Question: Which kind of chart has been used to present this data?
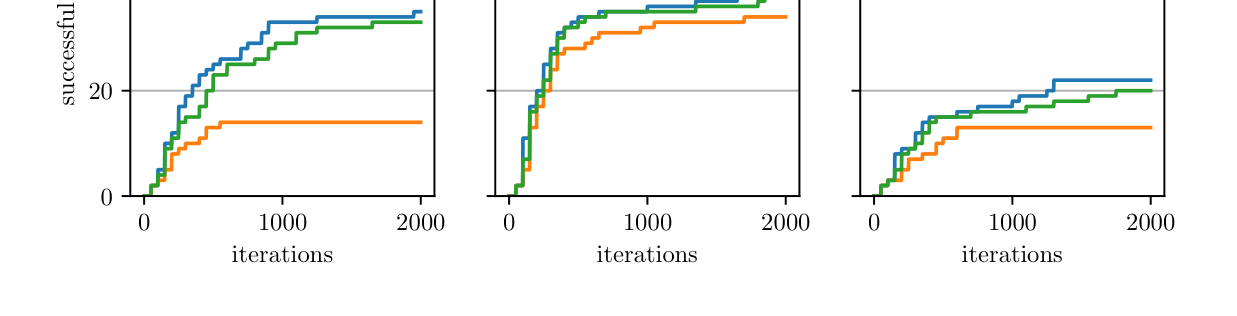
Answer: line